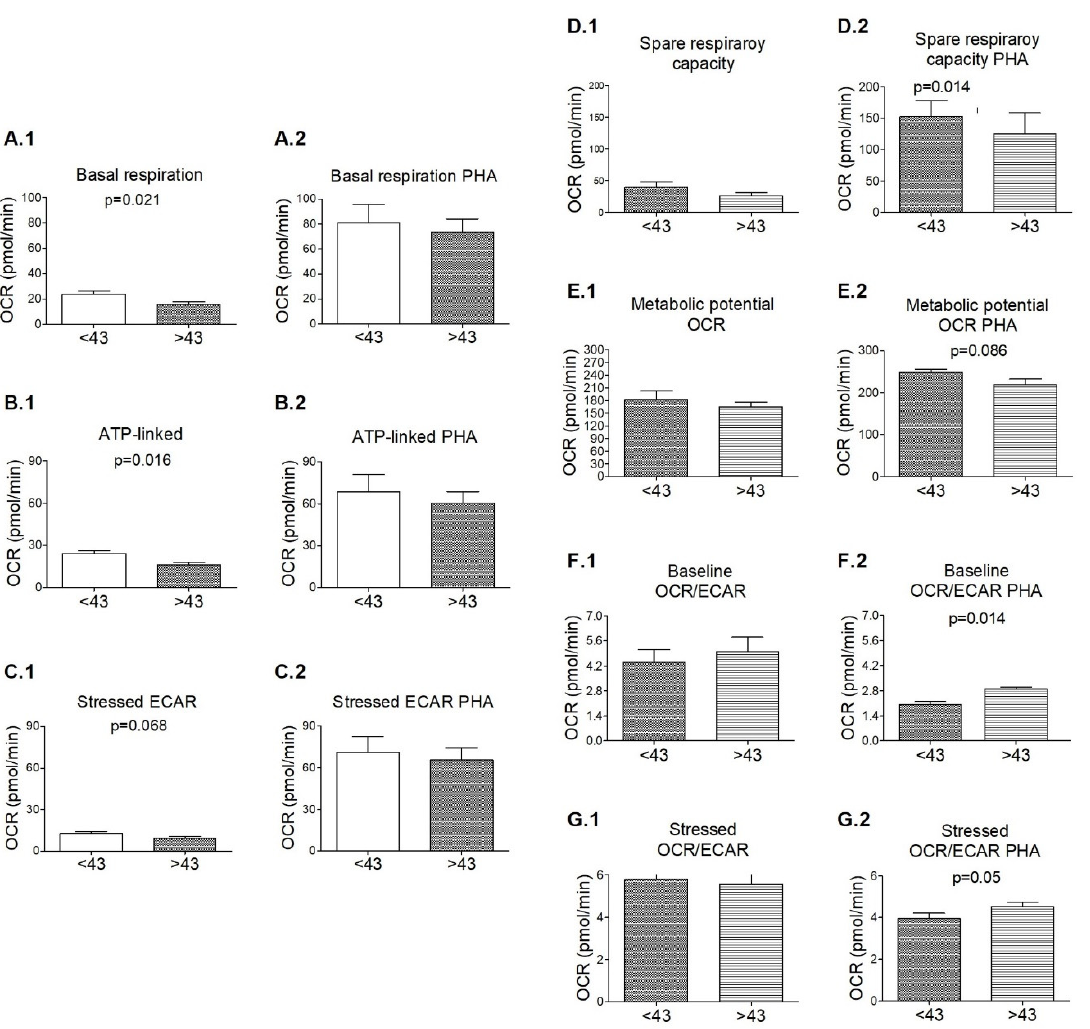
Figure 5. Mitochondrial function of the PBMCs from ( A ) healthy donors (HDs) and ( B ) MS patients with lipid-specific oligoclonal immunoglobulin M bands (LS-OCMB) (M+) depending on age. The indexes of mitochondrial function were calculated from the oxygen consumption rate (OCR) and extracellular acidification rate (ECAR) profiles of non-stimulated ( 1 ) and PHA-stimulated ( 2 ) PBMCs: Basal respiration ( A ), ATP-linked ( B ), stressed ECAR ( C ), spare respiratory capacity ( D ), metabolic potential OCR ( E ), baseline OCR/ECAR ( F ) and stressed OCR/ECAR ( G ). Healthy donors (HDs) younger than 43 years old (<43) = 9, HDs older than 43 years old (>43) = 8. M+ < 43 = 5, M − > 43 = 4. PHA = phytohemagglutinin. Data were expressed as mean ± s.e.m. Comparisons were eva-luated with the non-parametric test U Mann-Whitney.